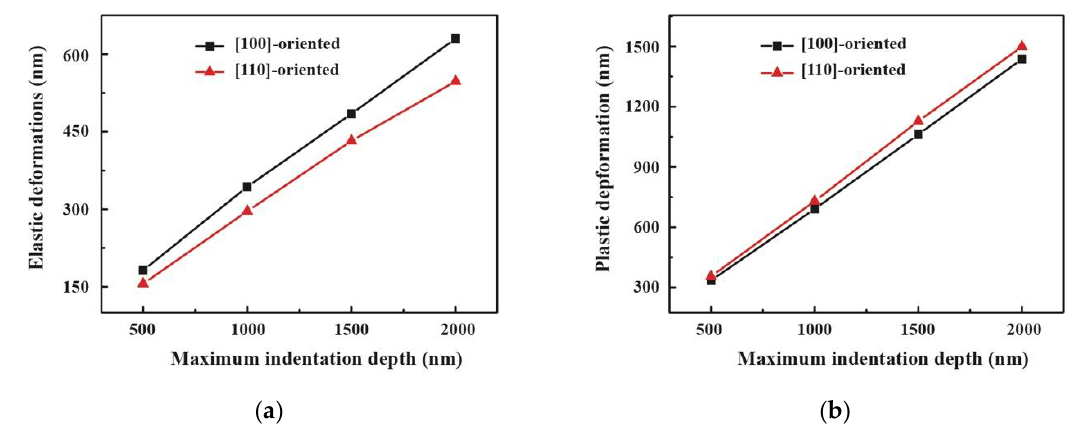
Figure 3. ( a ) Elastic deformation and ( b ) plastic deformation versus maximum indentation depth